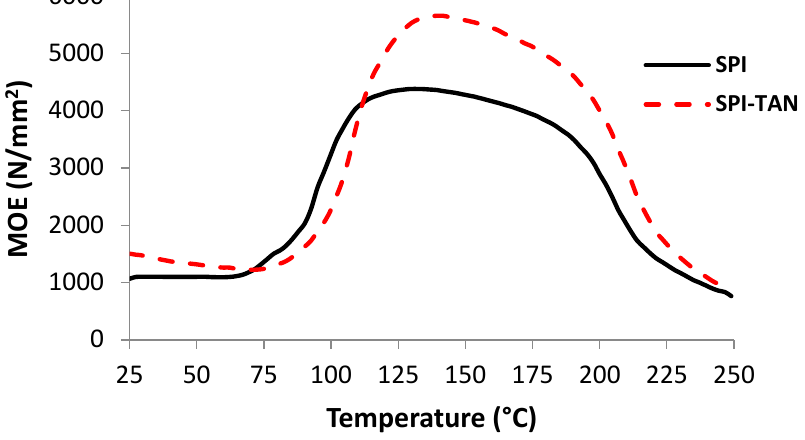
Figure 2. Thermo-mechanical analysis of quebracho tannin–soy protein adhesive. SPI: Soy protein isolate; TAN: Tannin